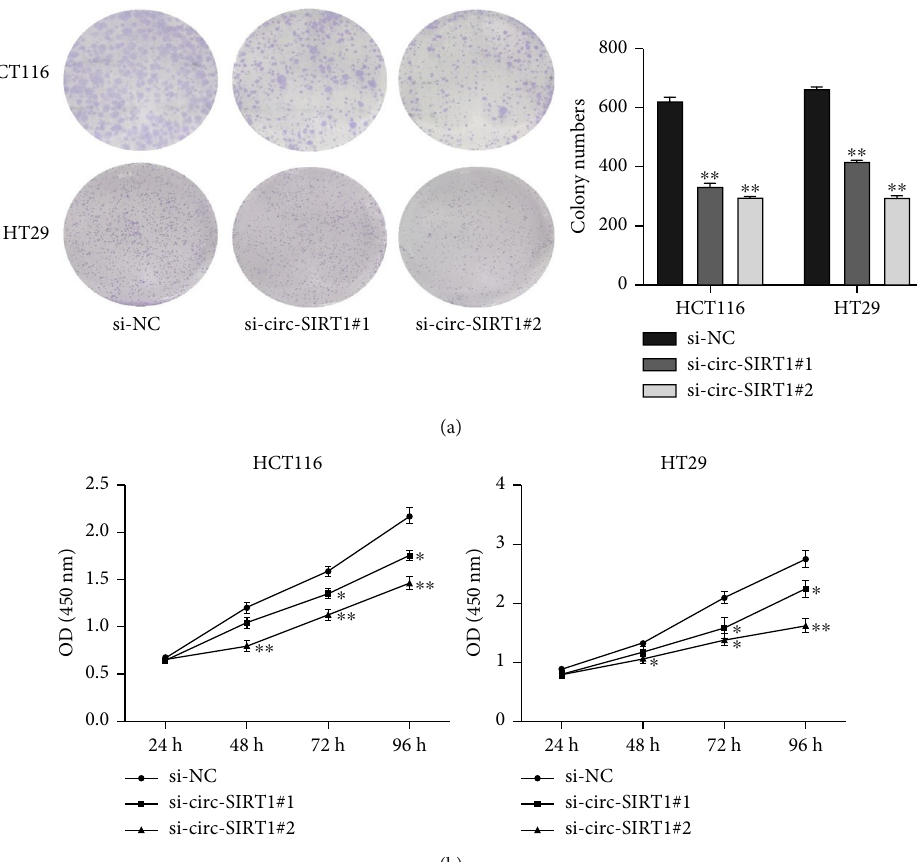
Figure 2: The e ff ect of downregulation of circ-SIRT1 expression on the proliferation of HCT116 and HT29 cells. Downregulation of cirC- SIRT1 expression inhibited the proliferation of HCT116 and HT29 cells (a) and (b). ∗ stands for P < 0 : 05 , ∗∗ stands for P < 0 : 01 , ∗∗∗ stands for P < 0 : 001